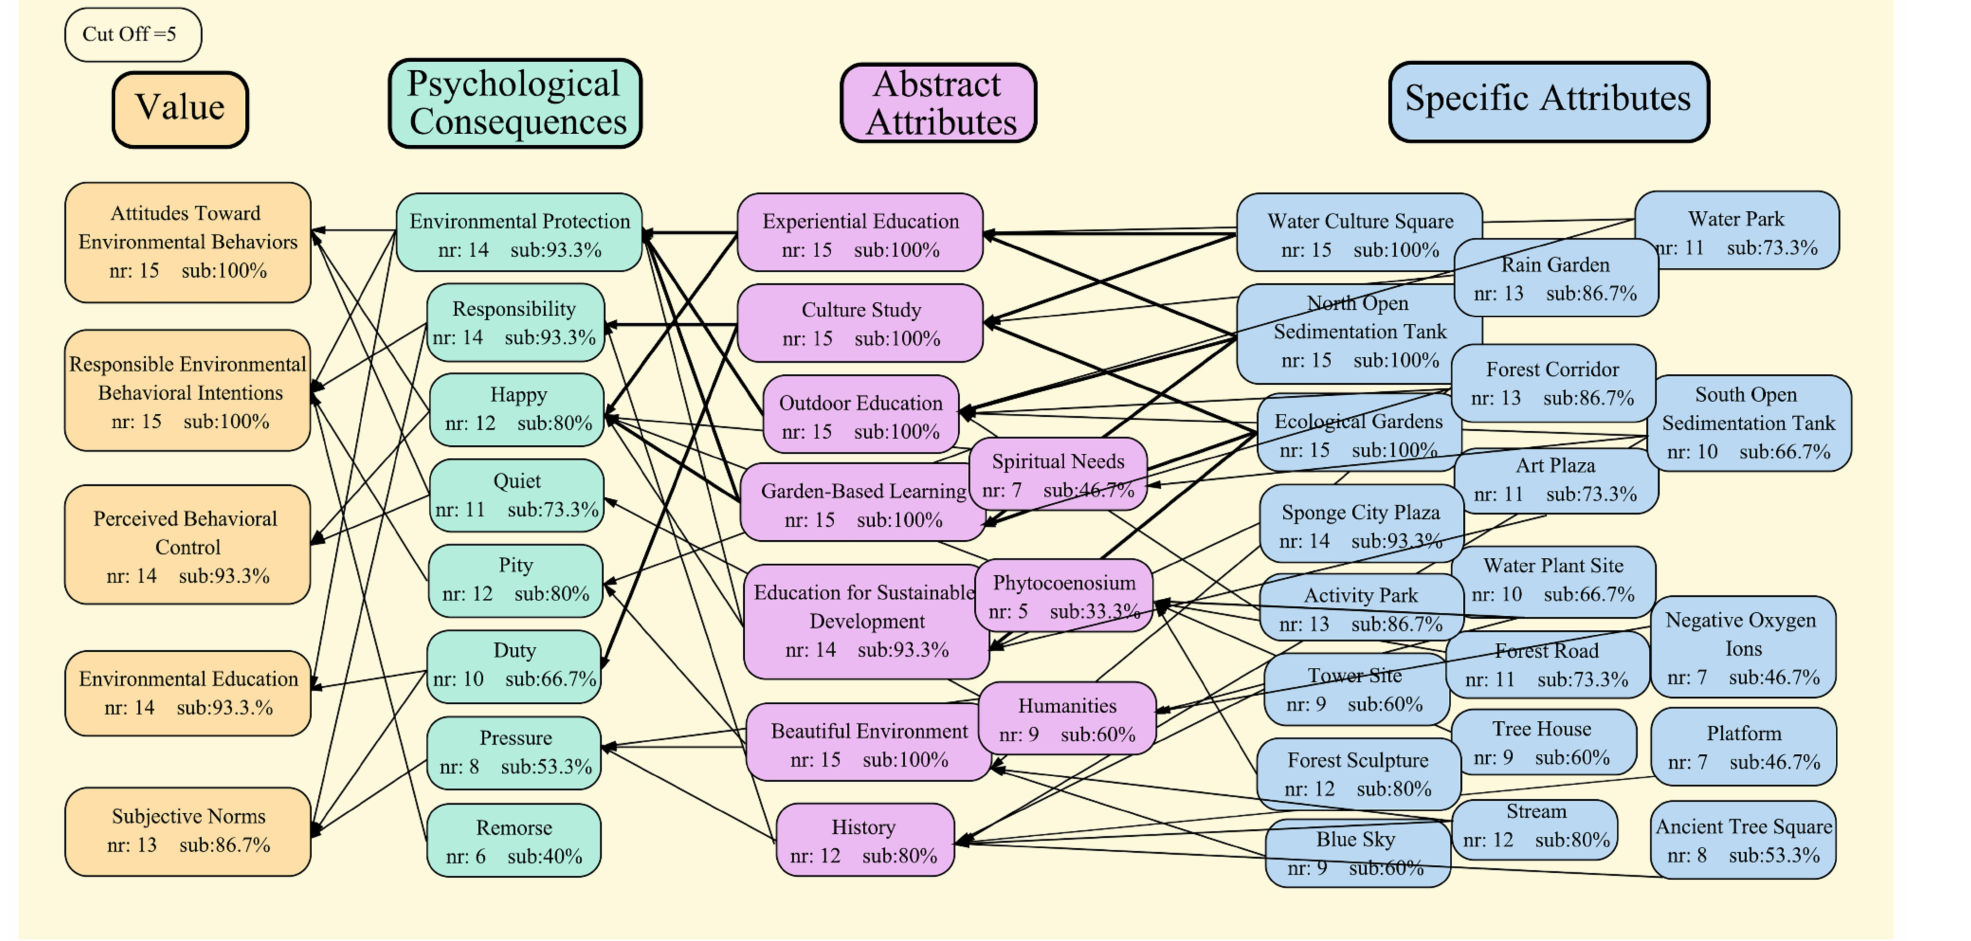
Figure 4. Consensus map developed using data from the 15